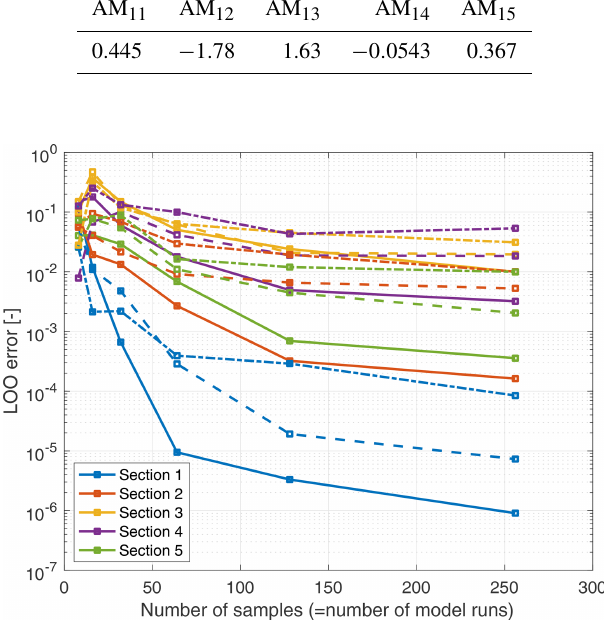
Figure C1. Surrogate model convergence for S 1 (dash–dot), S 2 (dashed), and S 3 (solid). Each data point corresponds to the average over five runs.